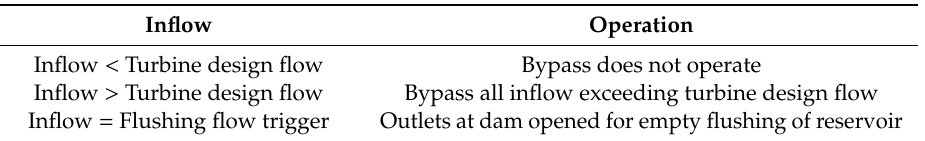
Table 2. Operating Strategy for Bypass around Sedimentation